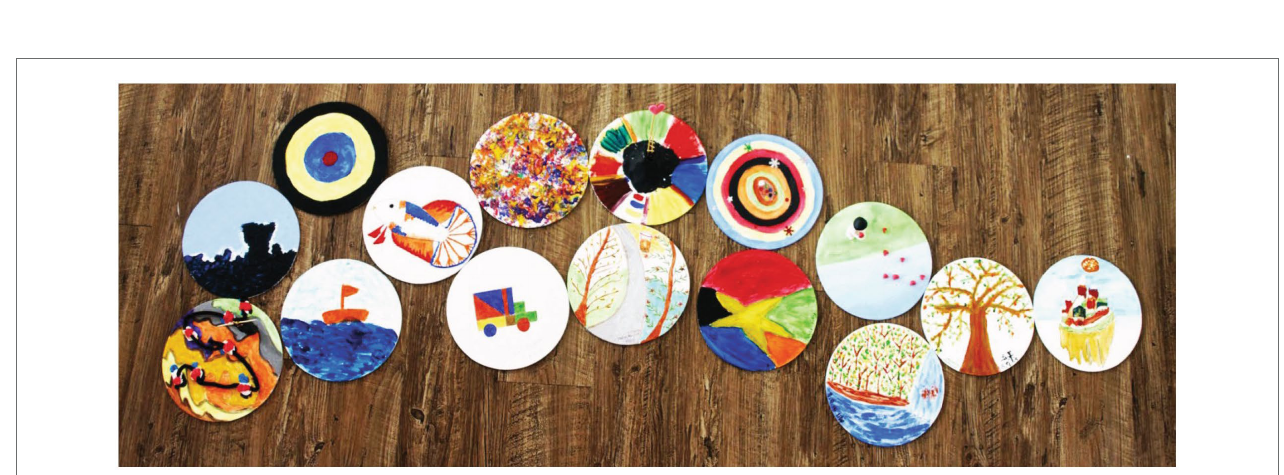
FIGURE 3 | Large group mural – ‘Seasons of Life’ (Acrylic on canvas).